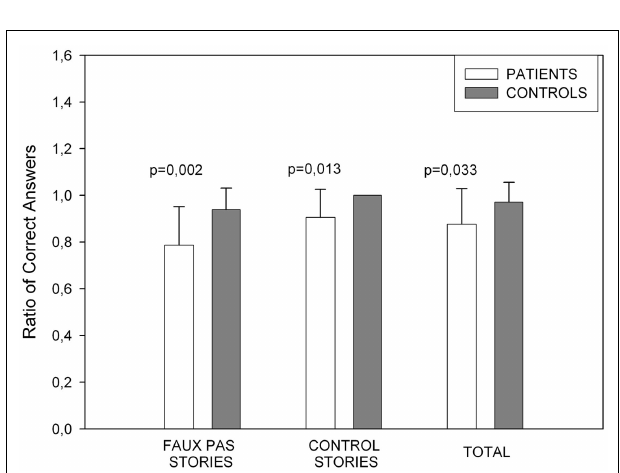
FIGURE 2 | Showing Faux pas task performance . The patients’ performance was poorer in all Faux Pas instances. In the control stories, controls obtained the maximum